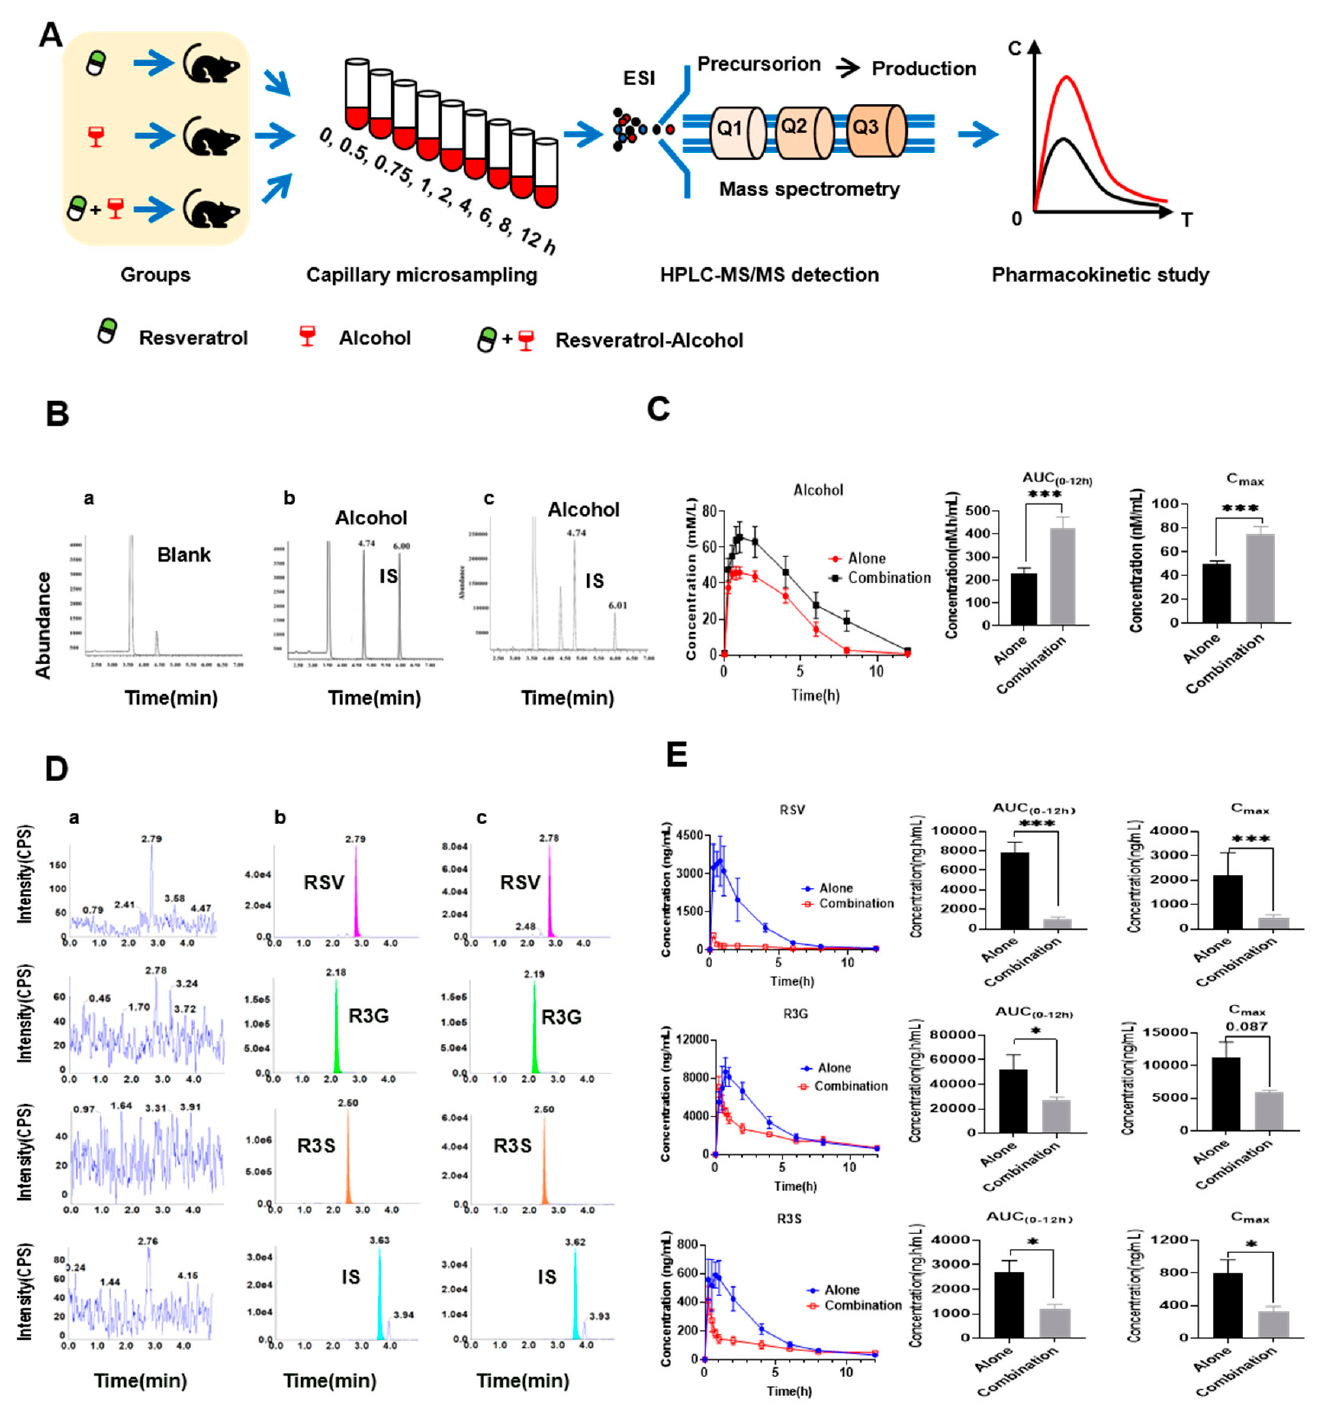
Figure 3. Pharmacokinetic interaction between RSV and alcohol. ( A ) Pharmacokinetic study design of RSV, alcohol and their combination in mice; ( B ) Typical multiple–reaction monitoring chromatograms of blank mouse blood(a), a blank mouse blood sample spiked with alcohol and IS(b), and a blood sample after the intragastric administration of alcohol (c). ( C ) Pharmacokinetics of alcohol in the alone and combination groups. ( D )Typical multiple-reaction monitoring chromatograms of blank mouse blood(a), a blank mouse blood sample spiked with RSV, R3G, R3S, and IS(b), and a blood sample after the intragastric administration of RSV(c). ( E ) Pharmacokinetics of RSV and its main metabolites in the alone and combination groups. * p < 0.05; *** p <